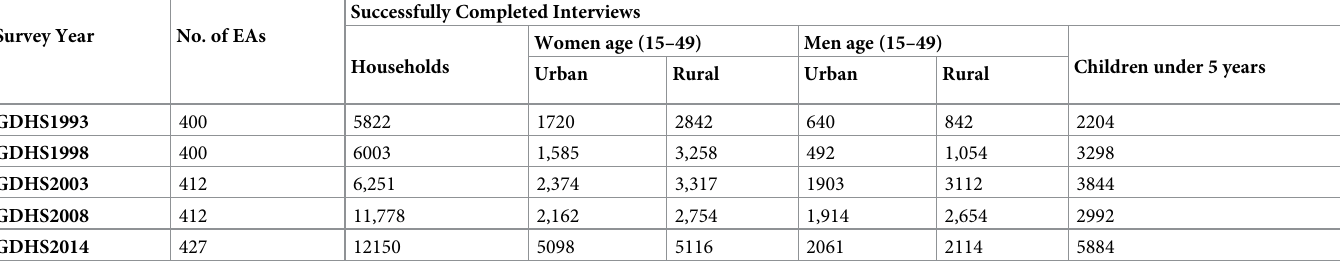
EAs = Enumeraiton